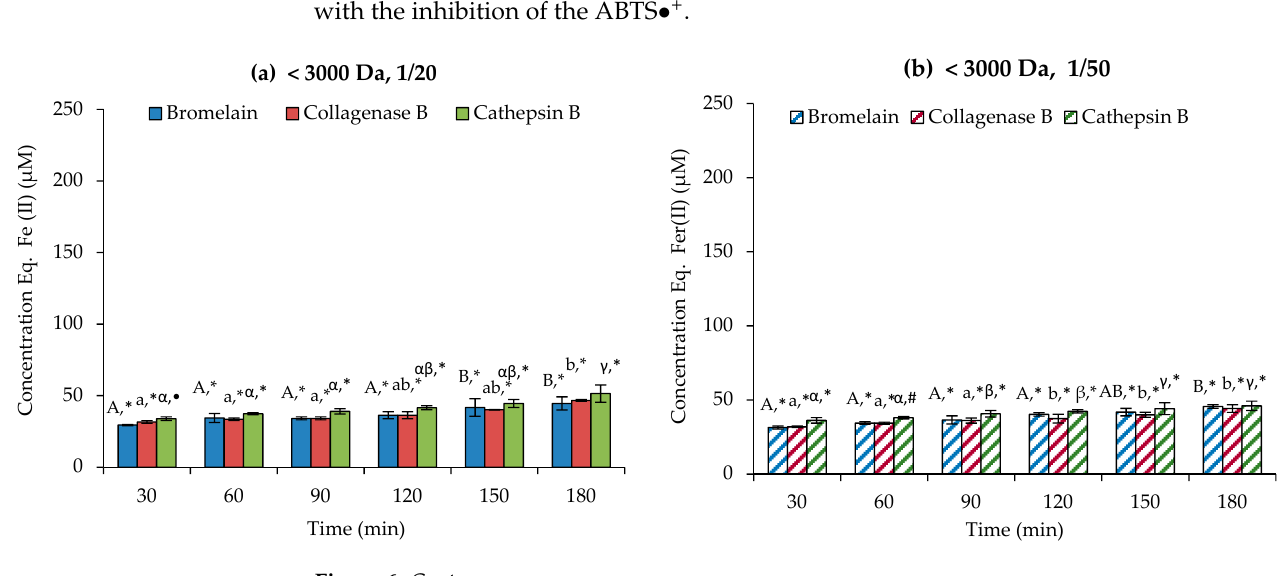
with the inhibition of the ABTS • + .